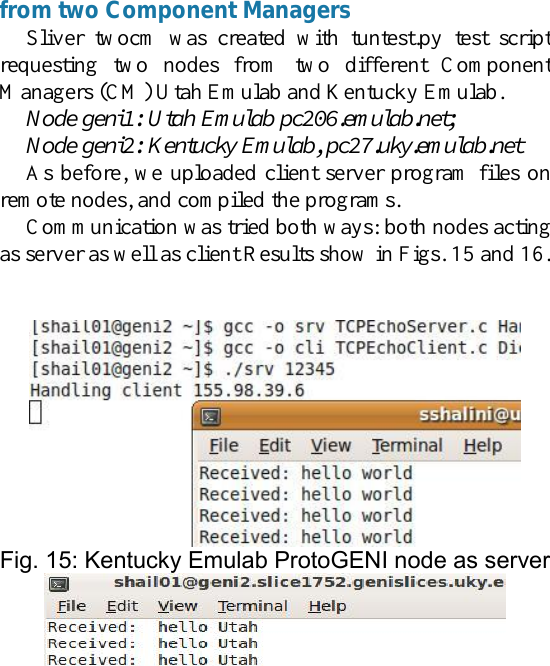
Fig. 13: Communication of a ProtoGENI sliver with outside network